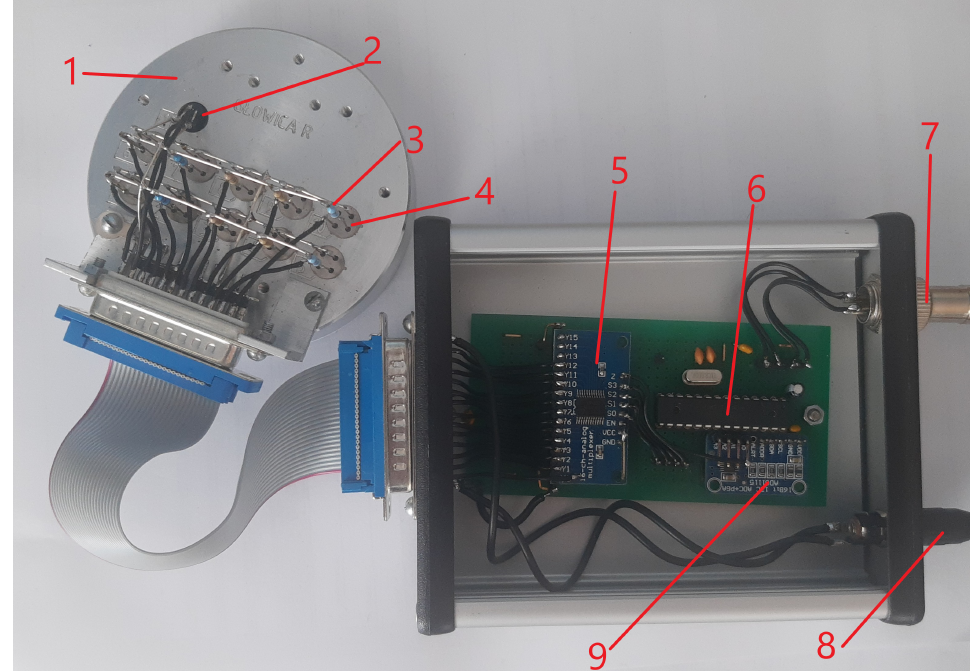
Figure 1. The PW6 electronic nose device. The cover was opened for the photo. 1—aluminium probe, 2—temperature and humidity sensors, 3—additional resistor, 4—TGS sensor, 5—16-channel